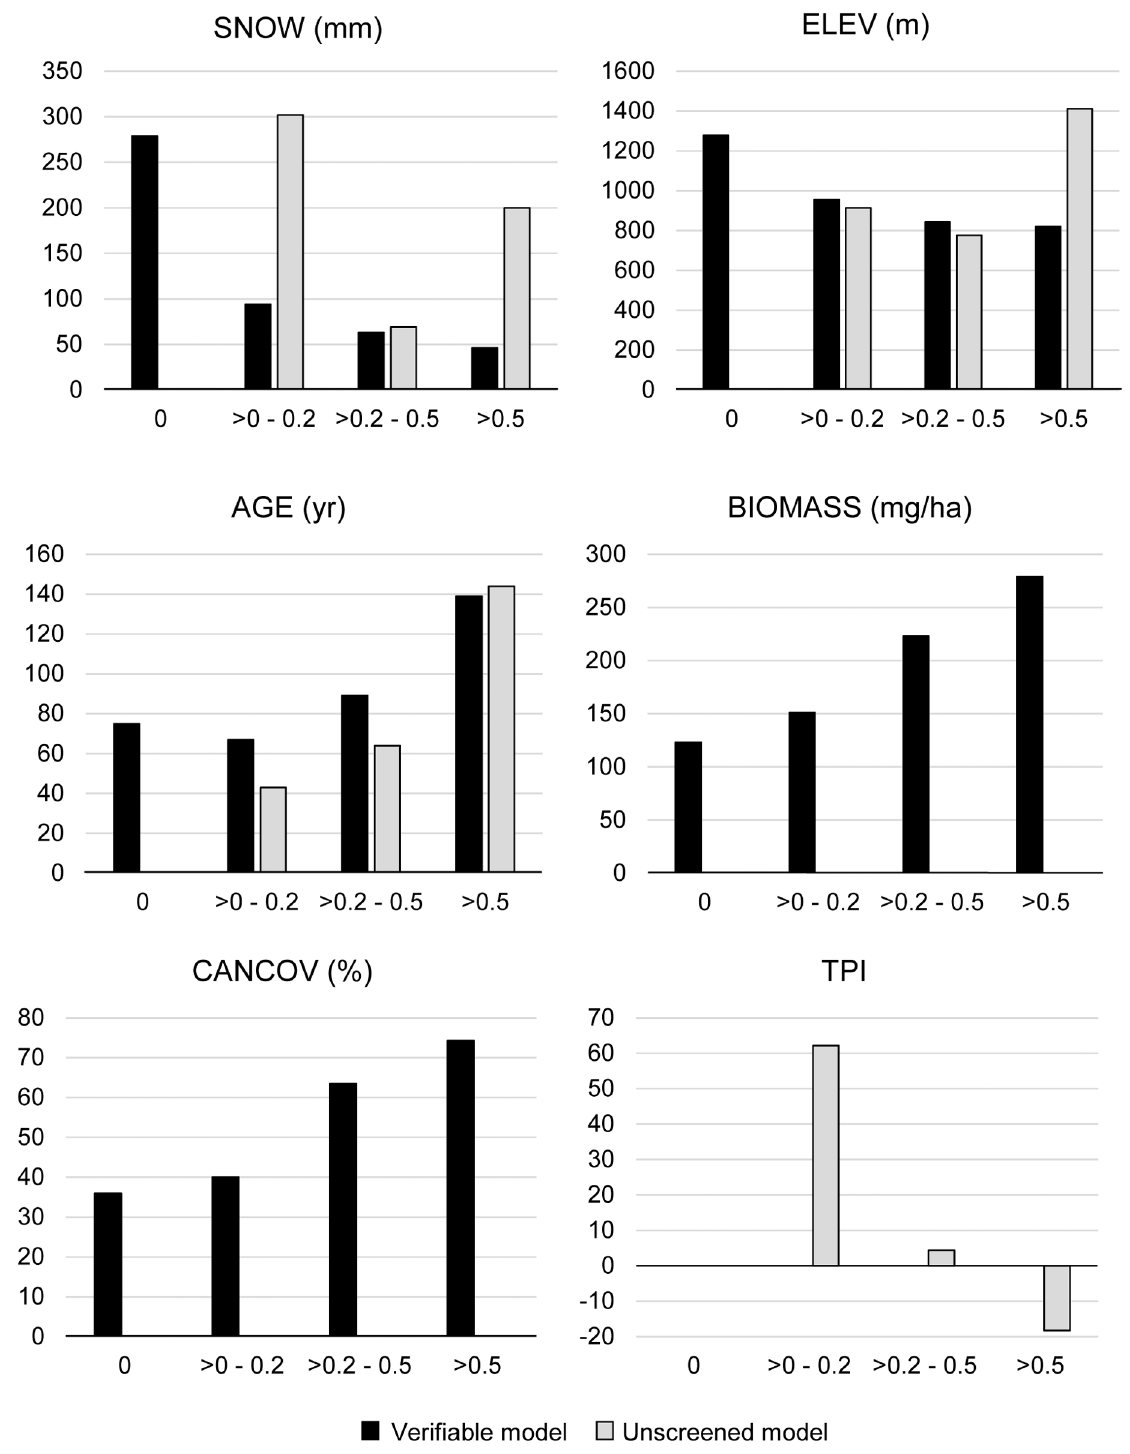
Fig 5. Mean values for continuous covariates included in the final verifiable and unscreened fisher distribution models by relative habitat quality classes. Elevation (ELEV) was not includedas a covariatein the modelingprocess, but is presented here to help elucidatethe contributionof SNOW to the final